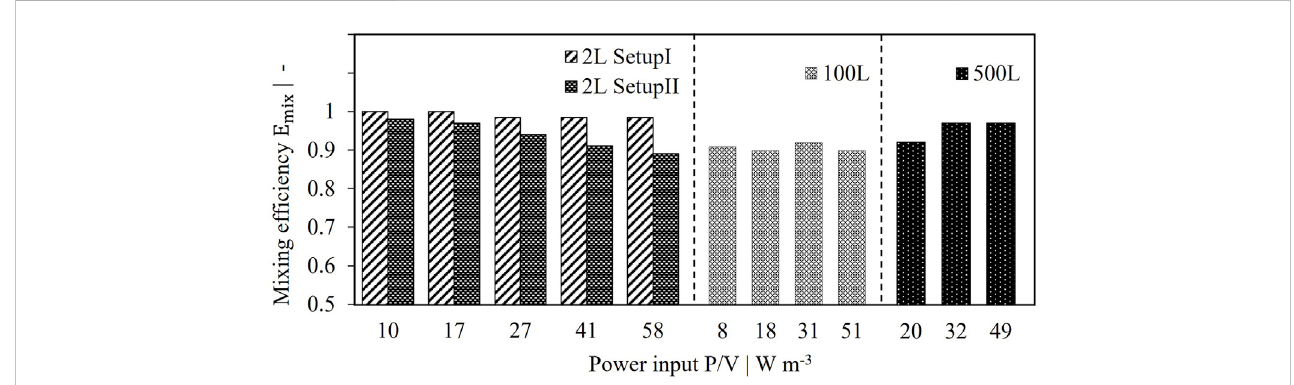
FIGURE 7 Comparison of mixing ef fi ciencies of 2 L, 100 L and 500 L perfusion systems.